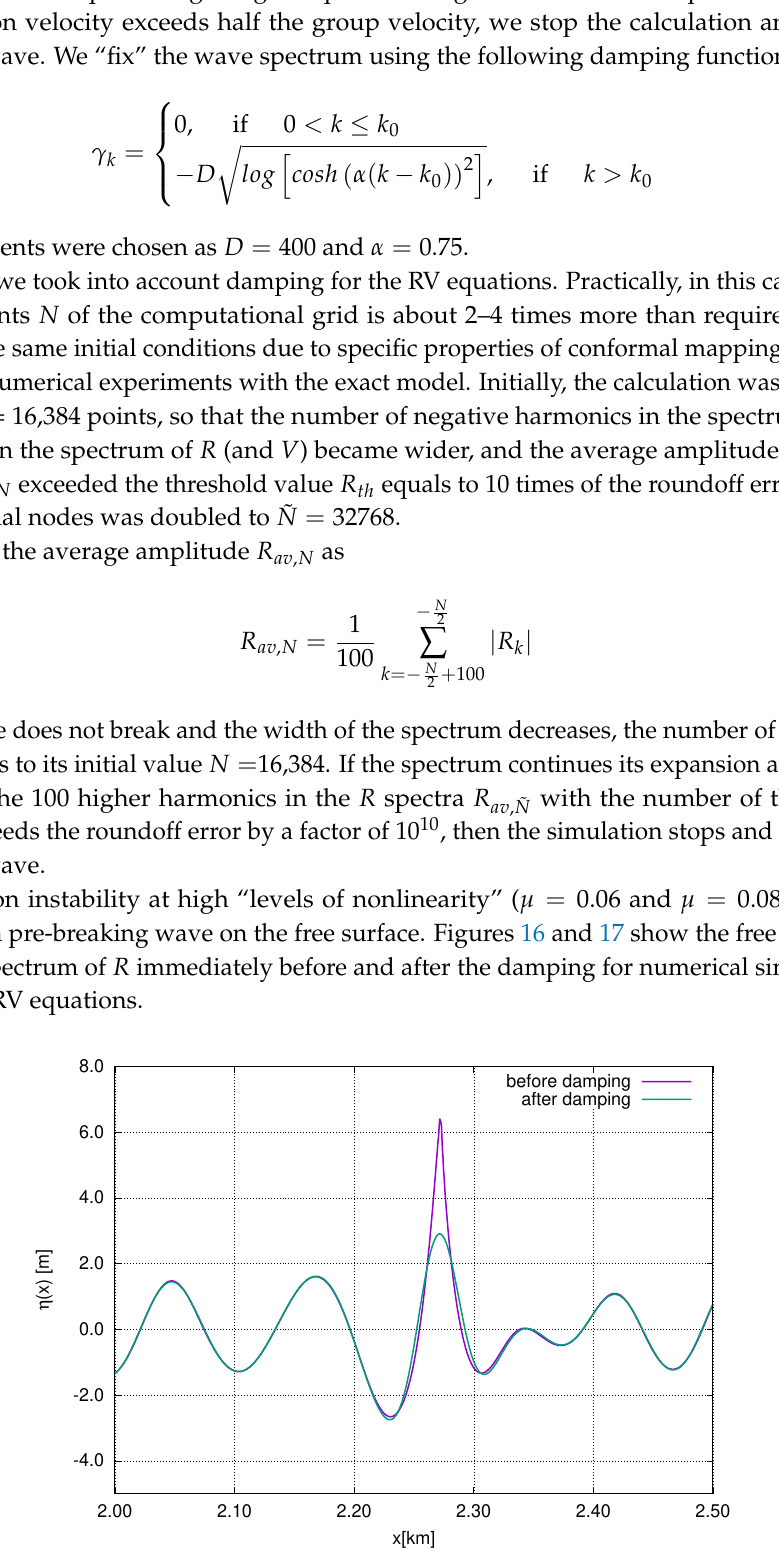
Figure 16. Surface profiles η ( x ) before (solid purple curve) and after (solid green curve) the